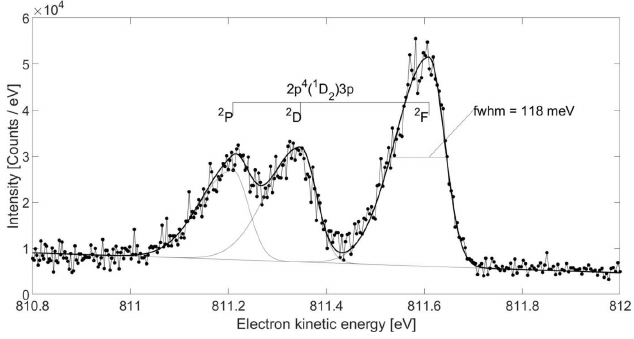
Figure 5 Resonant Auger spectrum of Ne following the 1s (cid:2) 1 3 p excitation at 867.17 eV, with 808 V retardation, measured at the storage ring.